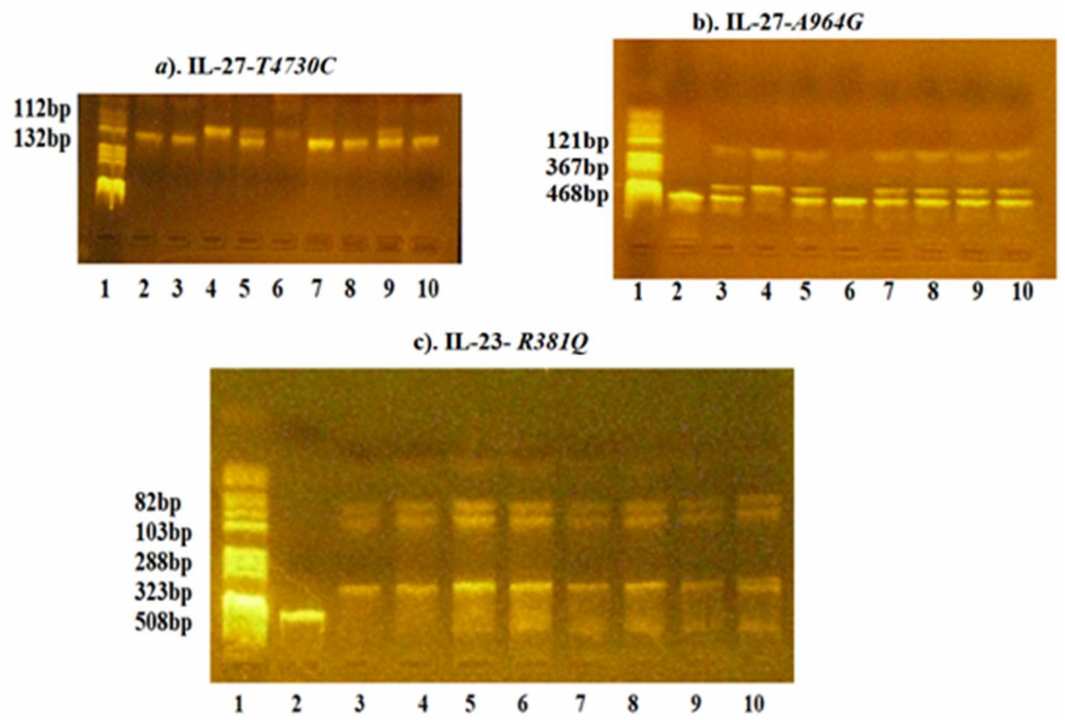
Figure 1. Agarose gel electrophoresis for identification of the genotypes for IL-27- T4730C , IL-27- A964G and IL-23- R381Q polymorphisms. ( a ). IL-27- T4730C : Lane 1—pBRHaeIII Digest DNA molecular marker V; Lane 2, 3, 7, 8, 10—TT genotype: fragment of 132bp; Lane 4, 6—CC geno- type: fragment of 112bp; Lane 5, 9—TC genotype: fragments of 132 and 112bp; ( b ). IL-27- A964G